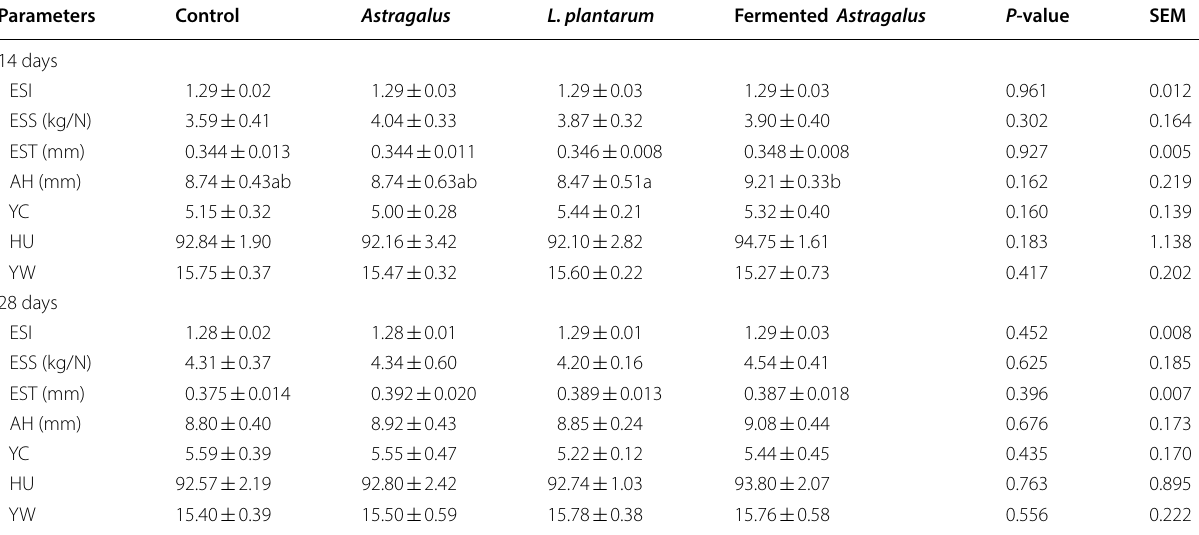
Table 4 Effects of different dietary supplements on the egg quality Parameters